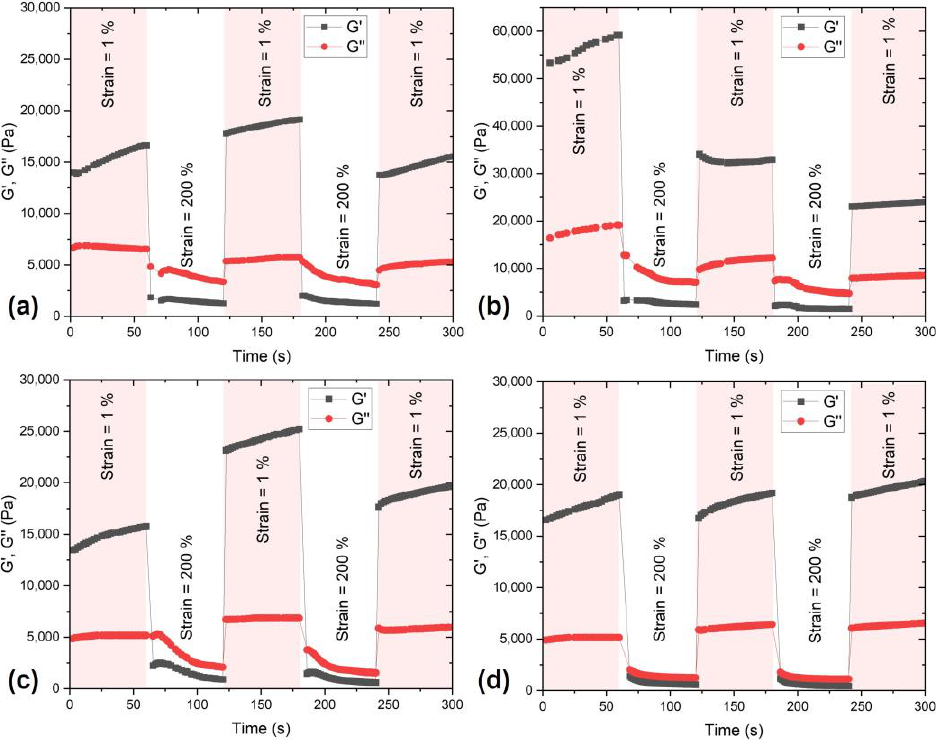
Figure 4. Self-healing efficiency evaluated by alternating the low (1%) and high (200%) shear strain of hydrogels: ( a ) PVA, ( b ) PVA/AG, ( c ) PVA/CMC, and ( d ) PVA/Xan.